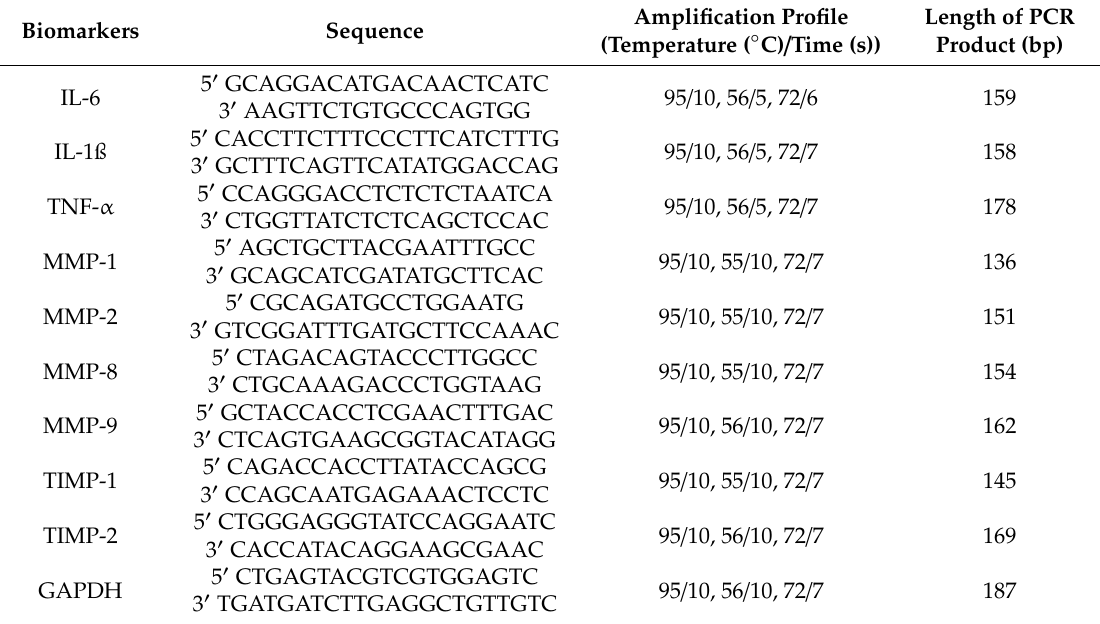
Table 1. Primer sequences, amplification profile and estimated length of the PCR product for each biomarker